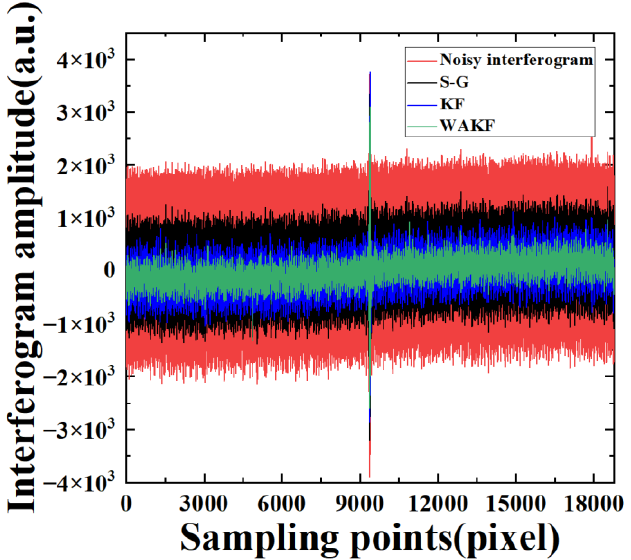
Figure 2. The amplitudes of the interferogram as a function of sampling points for the interferogram of the 747th pixel at a sampling frequency of 80 MHz.